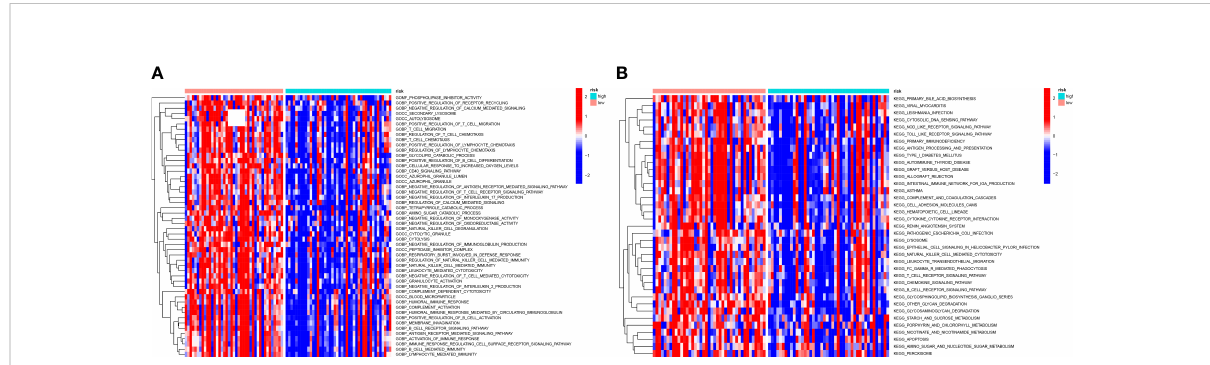
FIGURE 9 GSVA analysis of the two risk groups. (A) A heatmap conducted utilizing the GO gene set to estimate the variation of the two groups. There are many immune-relevant biology processes (GOBP) were downregulated in high-OS group. (B) A heatmap conducted utilizing the KEGG gene set to estimate the variation of the two groups, which also shows a signi fi cant change of immune-relevant pathways in high-OS